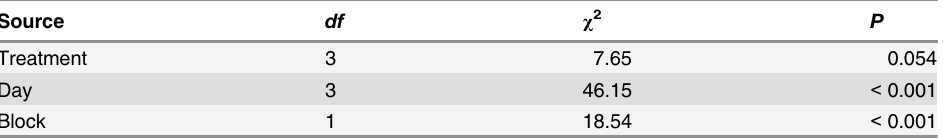
Table 5. Generalized linear model of the effects of injection of molecular-weight fractions of male ac- cessory gland extract (treatment), the day at which females were offered a mating (days), and experi- mental block (block) on the number of dead females by day 3 after the injection of extracts (N = 20 – 36 females per day, block and treatment group). Source df χ 2 P Treatment Block < 0.001 Non-signi fi cant interactions were removed to avoid